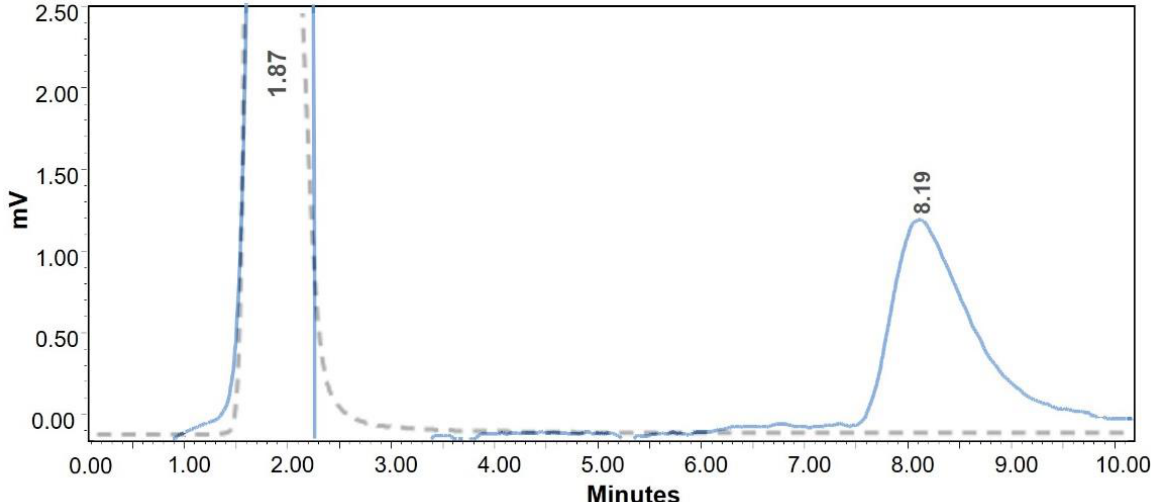
Figure 5. HPLC-PDA chromatogram obtained from the cosmetic cream (blue line) superimposed to a chromatogram of a black cream sample (grey spiked line). Chromatographic conditions: BEH XBridge ® -HILIC analytical column; mobile phase: 40 mM ammonium formate aqueous solution/acetonitrile (30:70, v/v ), flow rate 0.25 mL min − 1 at 214 nm.